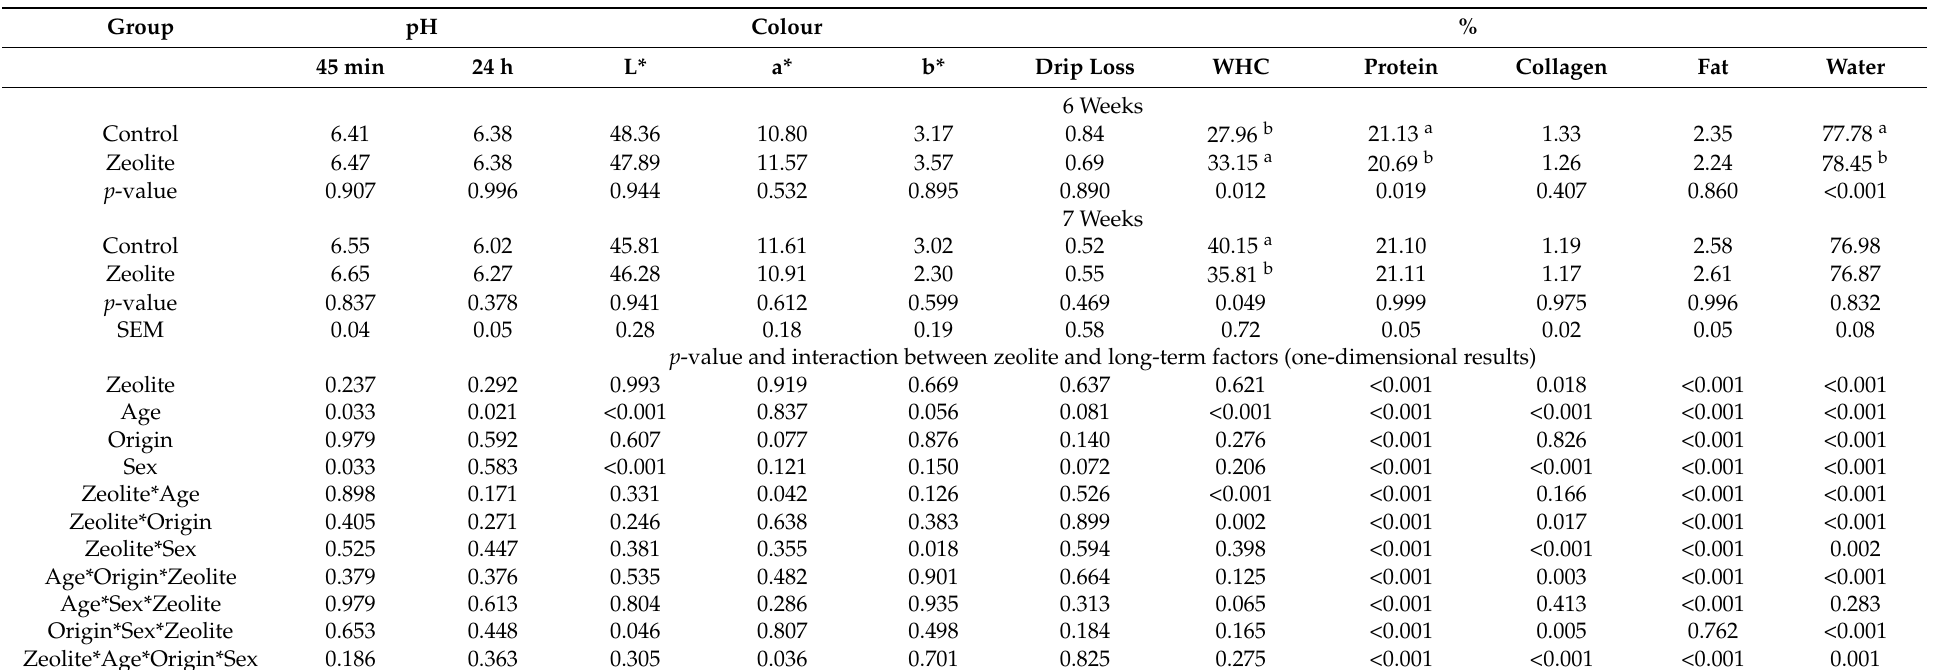
Table 6. Physicochemical parameters of breast muscles from broiler ducks